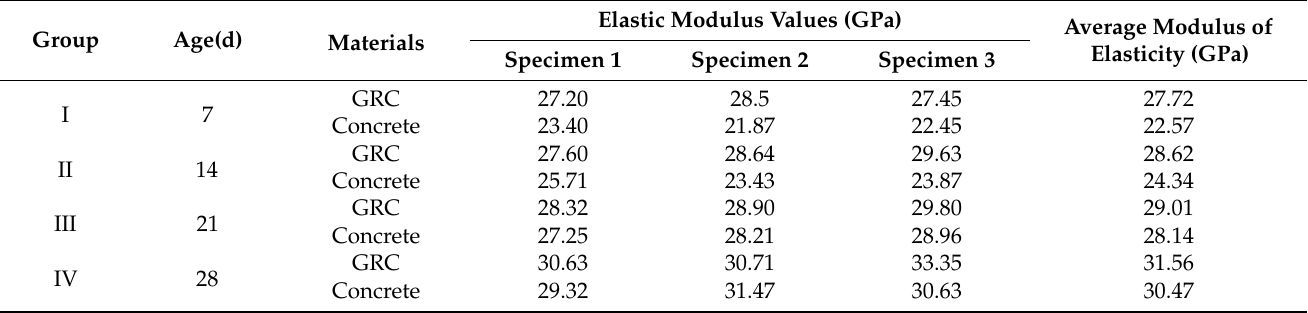
Table 5. Measurement results of elastic modulus